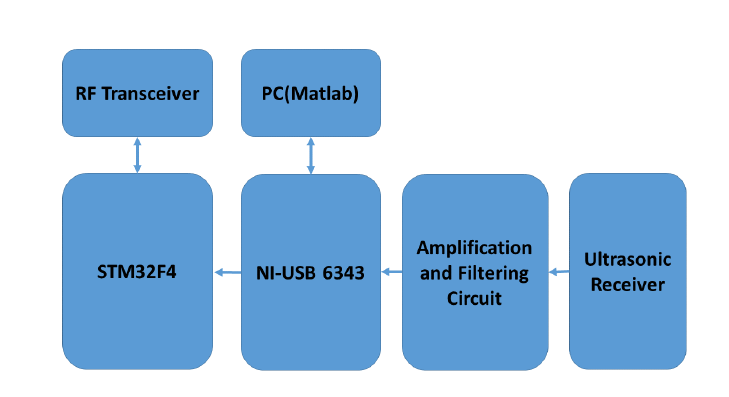
Figure 3. Block diagram of ultrasonic transmitter circuit (Mobile node).